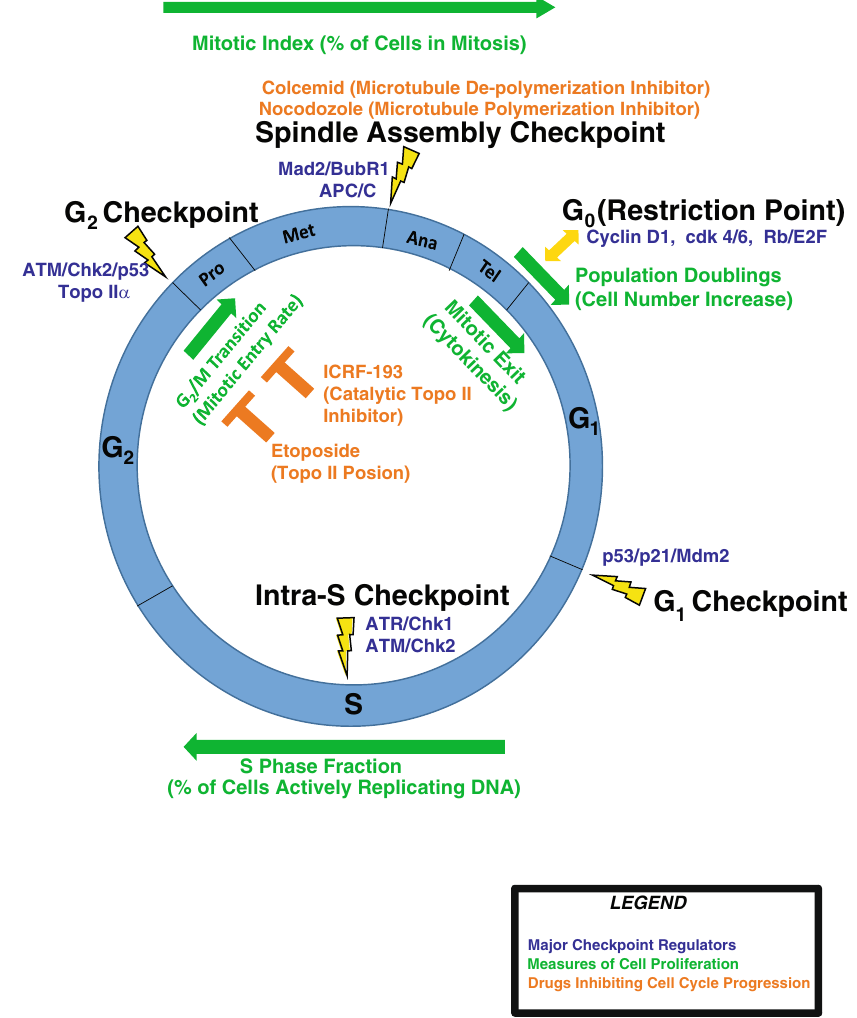
Fig. 1 Diagram of cell cycle regulation. Phases of the cell cycle are shown inside the blue circle in the center of the fi gure (G 0 , G 1 , S, G 2 , and mitosis which consists of several sub-phases: prophase (Pro), metaphase (Met), anaphase (Ana), and telophase (Tel)). The G 0 Restriction Point is designated with a yellow dual headed arrow to illustrate the reversible nature of cell cycle entry and quiescence. As cells progress through the cycle, exogenous perturbations can activate checkpoints that arrest cells during phase transitions (checkpoints are designated by yellow lightning bolts ). Several measures of cellular proliferation are shown in green and span the cell cycle phases in which these markers are present. Drugs that inhibit cell cycle progression are shown in orange with their targets and mechanisms of action designated in subsequent parentheses. Components of major regulatory pathways triggering each checkpoint are listed in dark blue font near the checkpoint in which they play a role. Precise control over the regulation of the cell cycle is a requirement for ensuring accurate DNA replication and cell